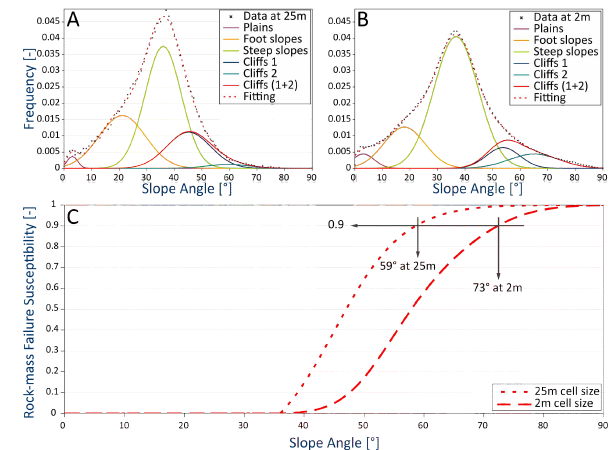
Fig. 11. (A) Normal distributions of the slope angles of the lime- stones HMA in the Bagnes Valley extracted from a 25m resolu- tion DEM. (B) Normal distributions of the slope angles of the same limestones HMA in the Bagnes Valley extracted now from a 2m resolution DEM. (C) Cumulative distribution functions are shown for the same limestone HMA, once with a 25m resolution DEM and once with a 2m